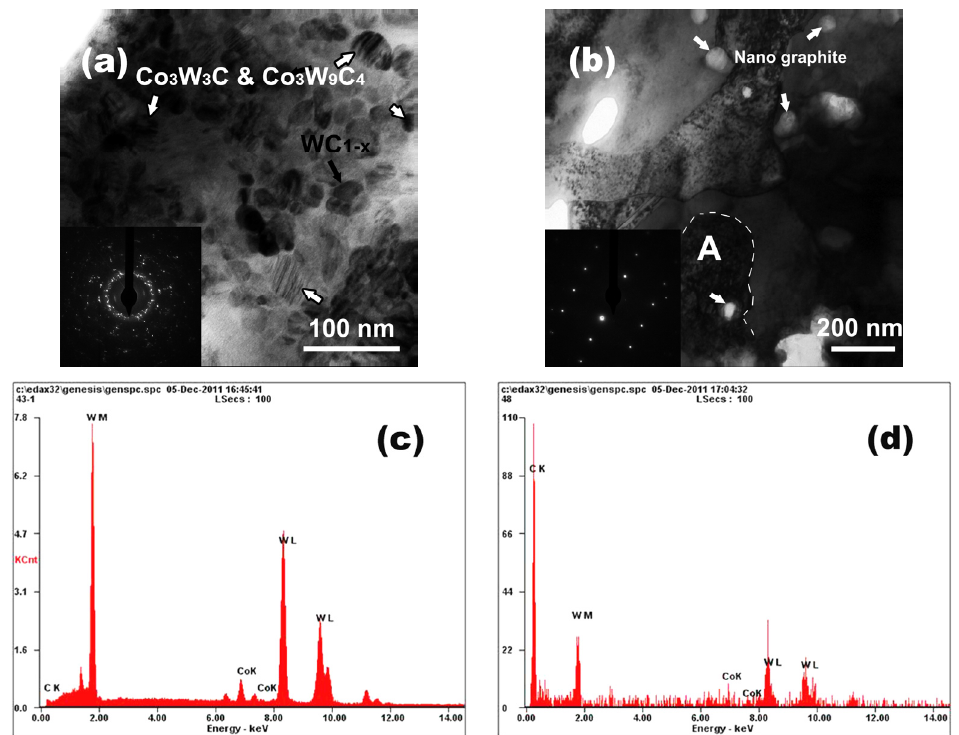
Figure 5. TEM observations of the nano domains ( a ) in Co-rich binder and ( b ) in WC-rich area; ( c ) the corresponding EDAX analysis in grain A; and ( d ) the corresponding EDAX analysis in graphite domains.